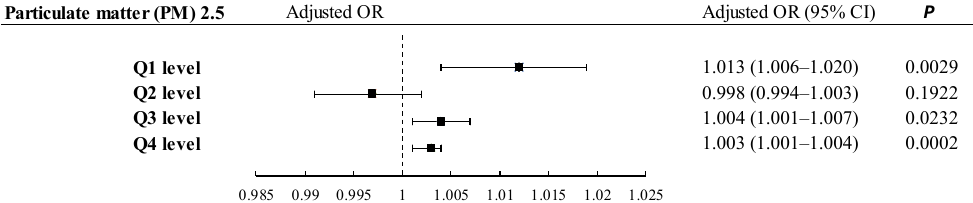
Figure 3. PM2.5 level subgroups analysis for the risk of glaucoma. Adjustment for gender, age, low-income, urbanization level, comorbidities. OR, odds ratio; CI, confidence interval. Table 3 Subgroups logic regression analysis of Particulate matter (PM)2.5 level and Glaucoma. Adjustment for gender, age, low-income, urbanization level, comorbidities. OR, odds ratio; CI, confidence interval. Particulate Matter ( PM ) 2.5 Level ( Reference: Q1 Level )